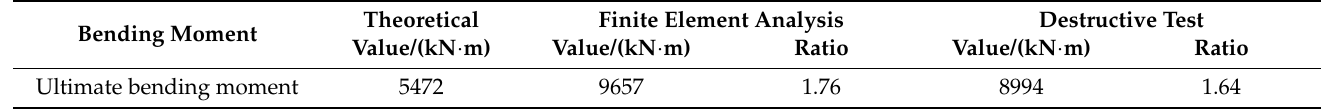
Table 9. Comparison of experimental and predicted values of damaged box girder with theoretical value.